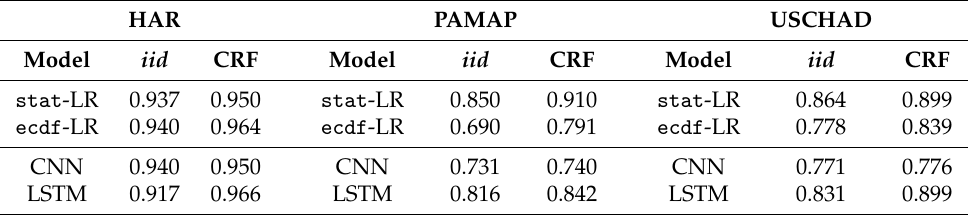
Table 4. Classification results obtained by the statistical models (top two rows) and the advanced neural network models (bottom two rows) on the HAR ( left ), PAMAP 2 ( middle ) and USCHAD ( right ) datasets with the configuration for window lengths of 3 s and accelerometer data sampled at 30 Hz. Results also show the results obtained with iid and Conditional Random Field